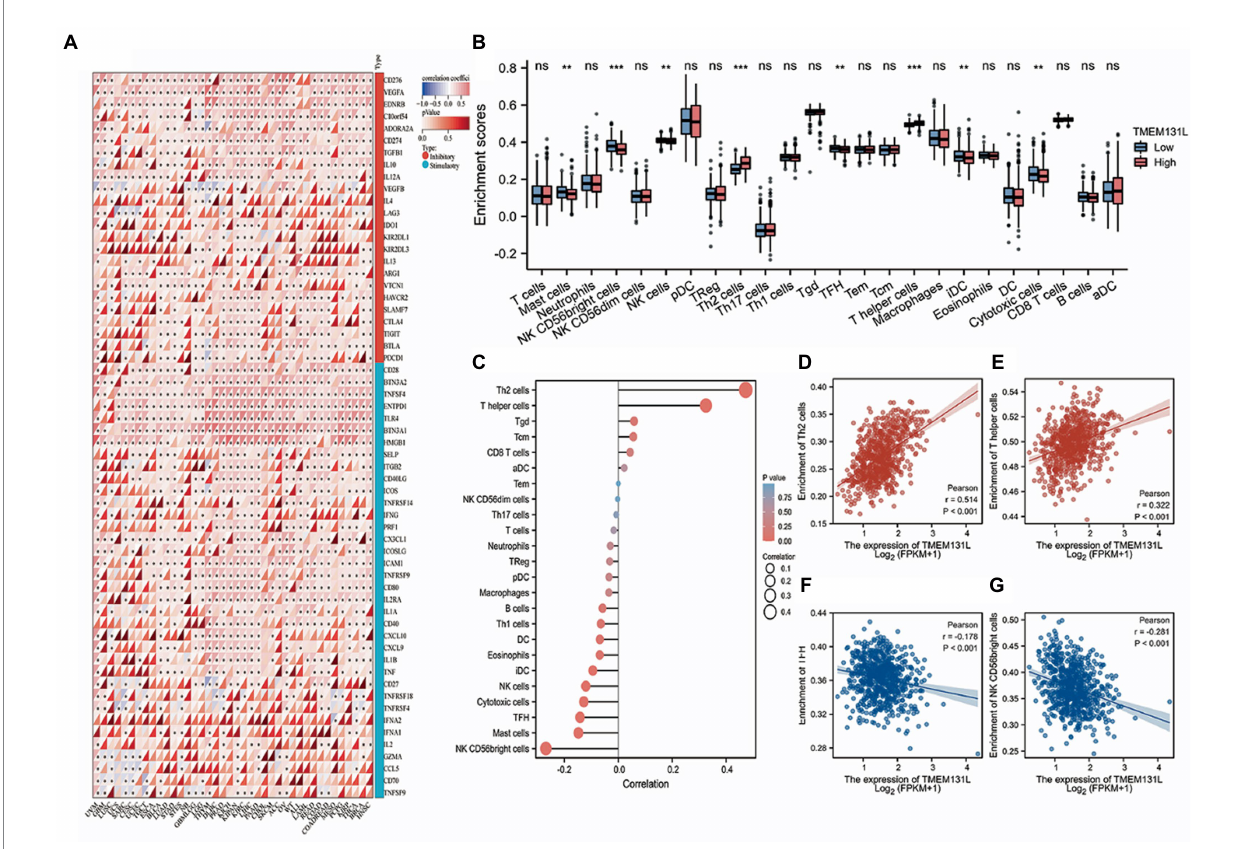
FIGURE 10 Analysis of immune cell infiltration. (A) The expression correlation heat map of TMEM131L and immune checkpoint; (B,C) Box plot and lollipop plot CIBERSORT analysis of the relationship between TMEM131L and 22 different types of immune cell infiltration; (D–G) CIBERSORT analysis showed that TMEM131L was significantly correlated with 22 kinds of immune cell infiltration.